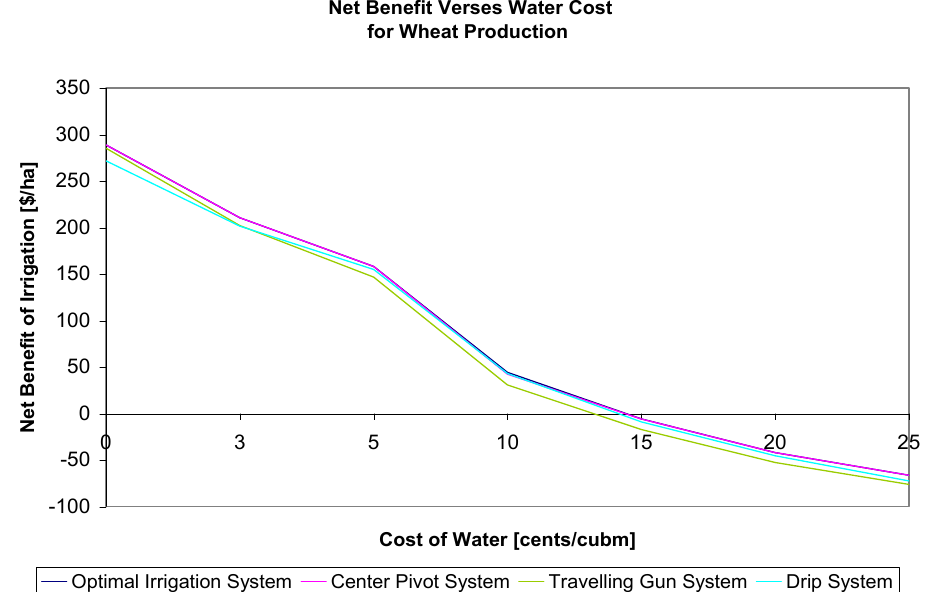
Figure 4. Irrigation system comparison of net benefit versus water cost associated with wheat pro- duction.